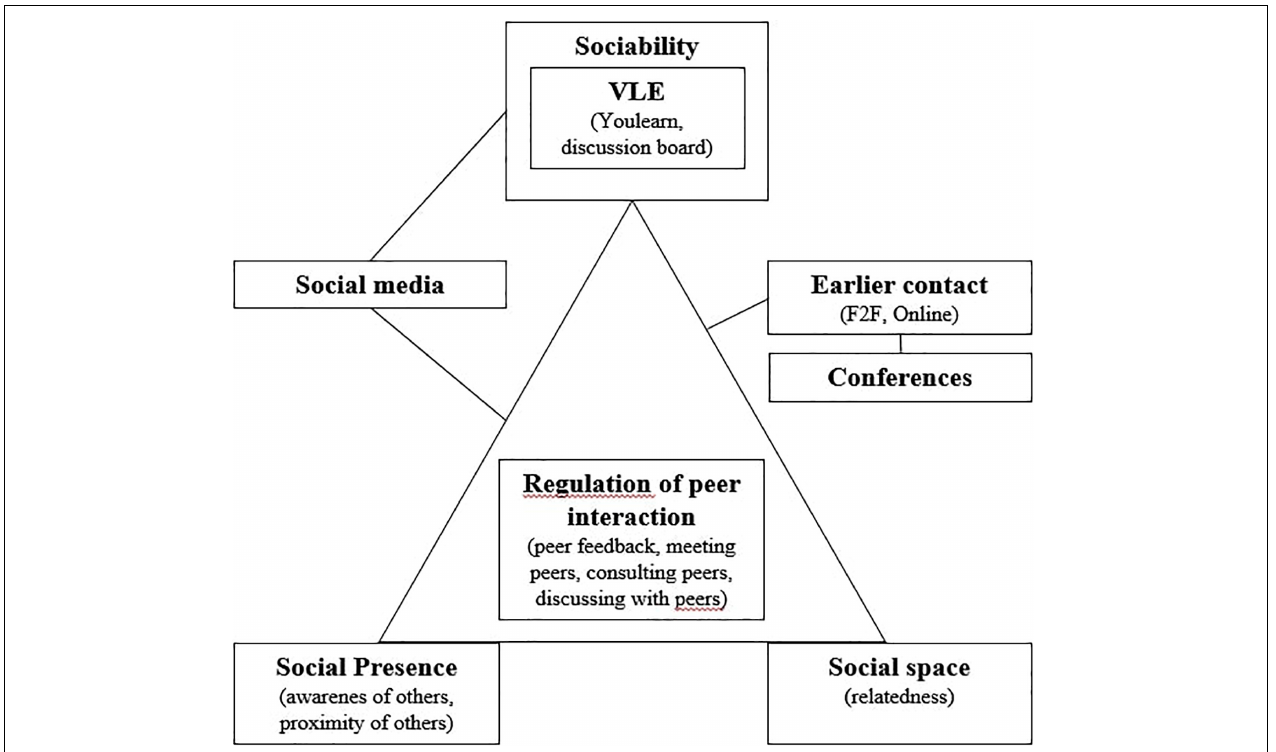
FIGURE 1 | The social space, social presence, and sociability triangle (adapted from Kreijns et al.,